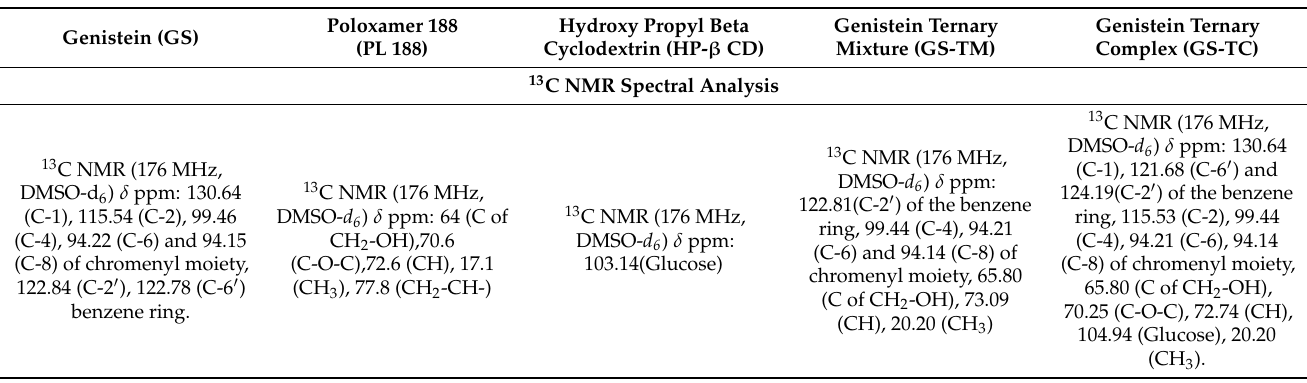
Table 2. NMR spectra value of pure genistein (GS), poloxamer 188 (PL 188), HP- β cyclodextrin (HP- β CD), genistein ternary mixture (GS-PM) and genistein ternary complex